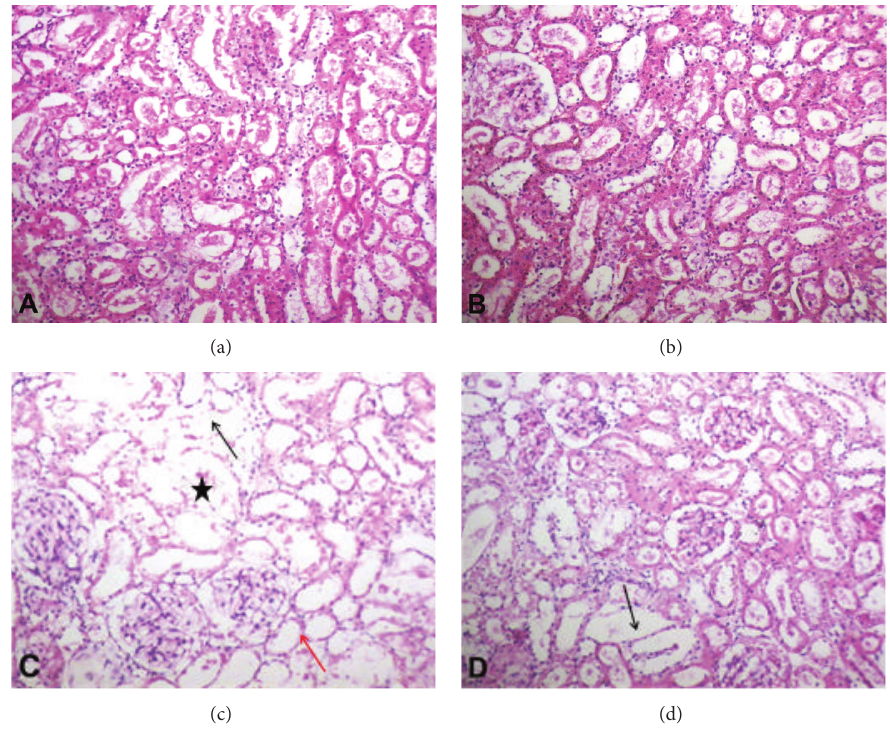
Figure 2: Effect of curcumin on kidney histopathological picture of methotrexate-induced nephrotoxicity in rats (H&E × 200). ((a) and (b)) Sections from control and curcumin-treated groups show normal histological pattern. (c) Methotrexate-treated group shows degeneration of the renal tubules with disruption of the basement membranes in-between the tubules (black arrow). Most of the renal tubules show cystic luminal dilatation and their lining cells are flat (red arrow). Degenerated glomeruli are also observed (star). (d) Kidney tissue from methotrexate plus curcumin treated rats; the histological features in section (c) are greatly improved and nearly back to normal appearance. Still few tubules were dilated